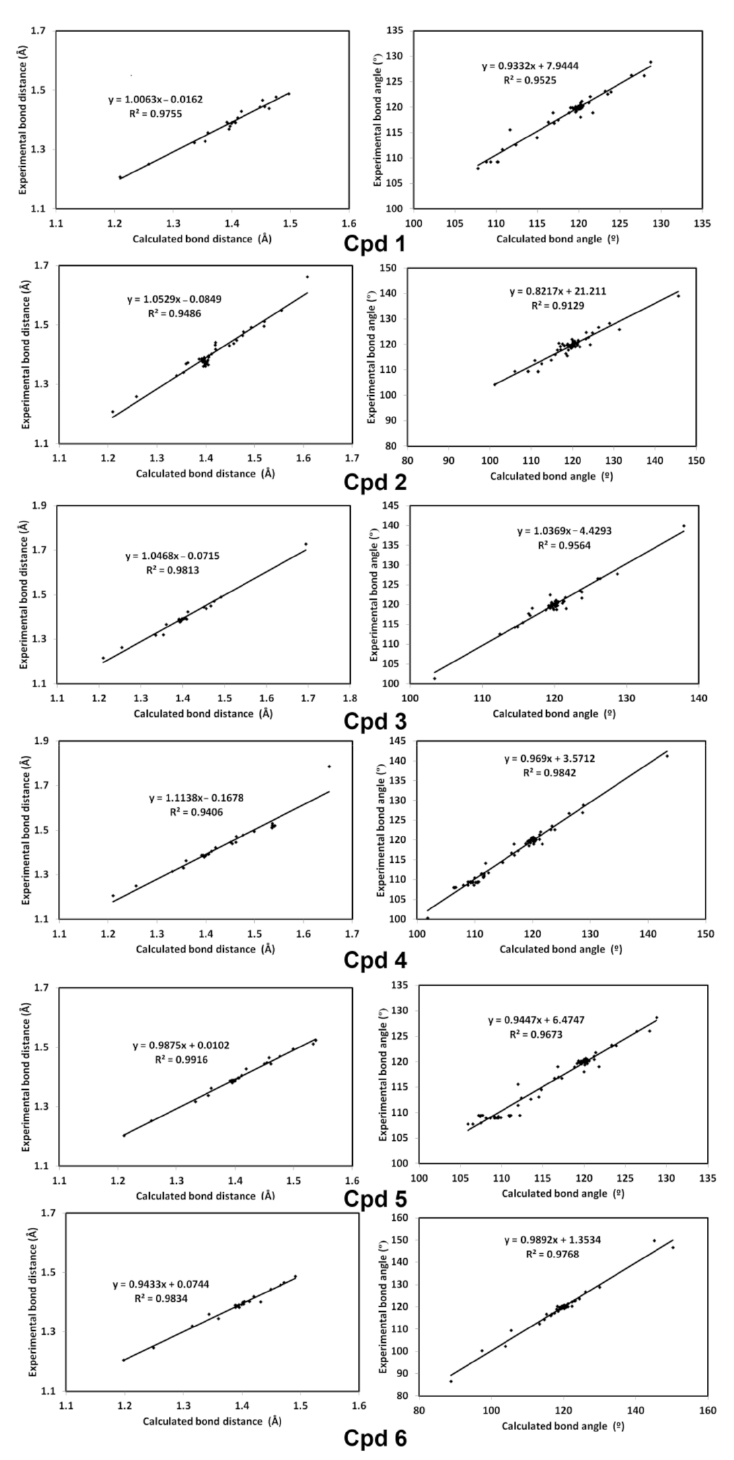
Figure 14. The straight line correlations between the calculated and experimental geometric pa- rameters. Detailed geometric parameters (bond distances and angles are listed in Tables S3–S8, Supplementary